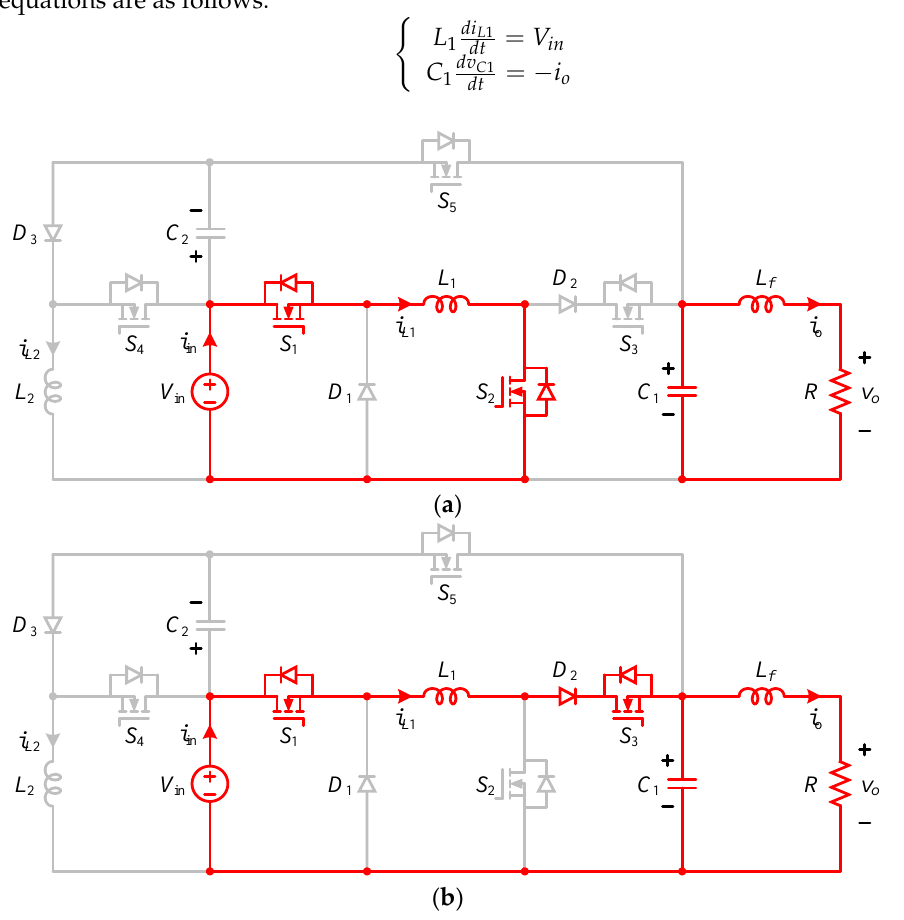
Figure 4. Equivalent circuits of the proposed CGBBI topology in interval 2 when v o > V in : ( a ) mode 1 and ( b ) mode